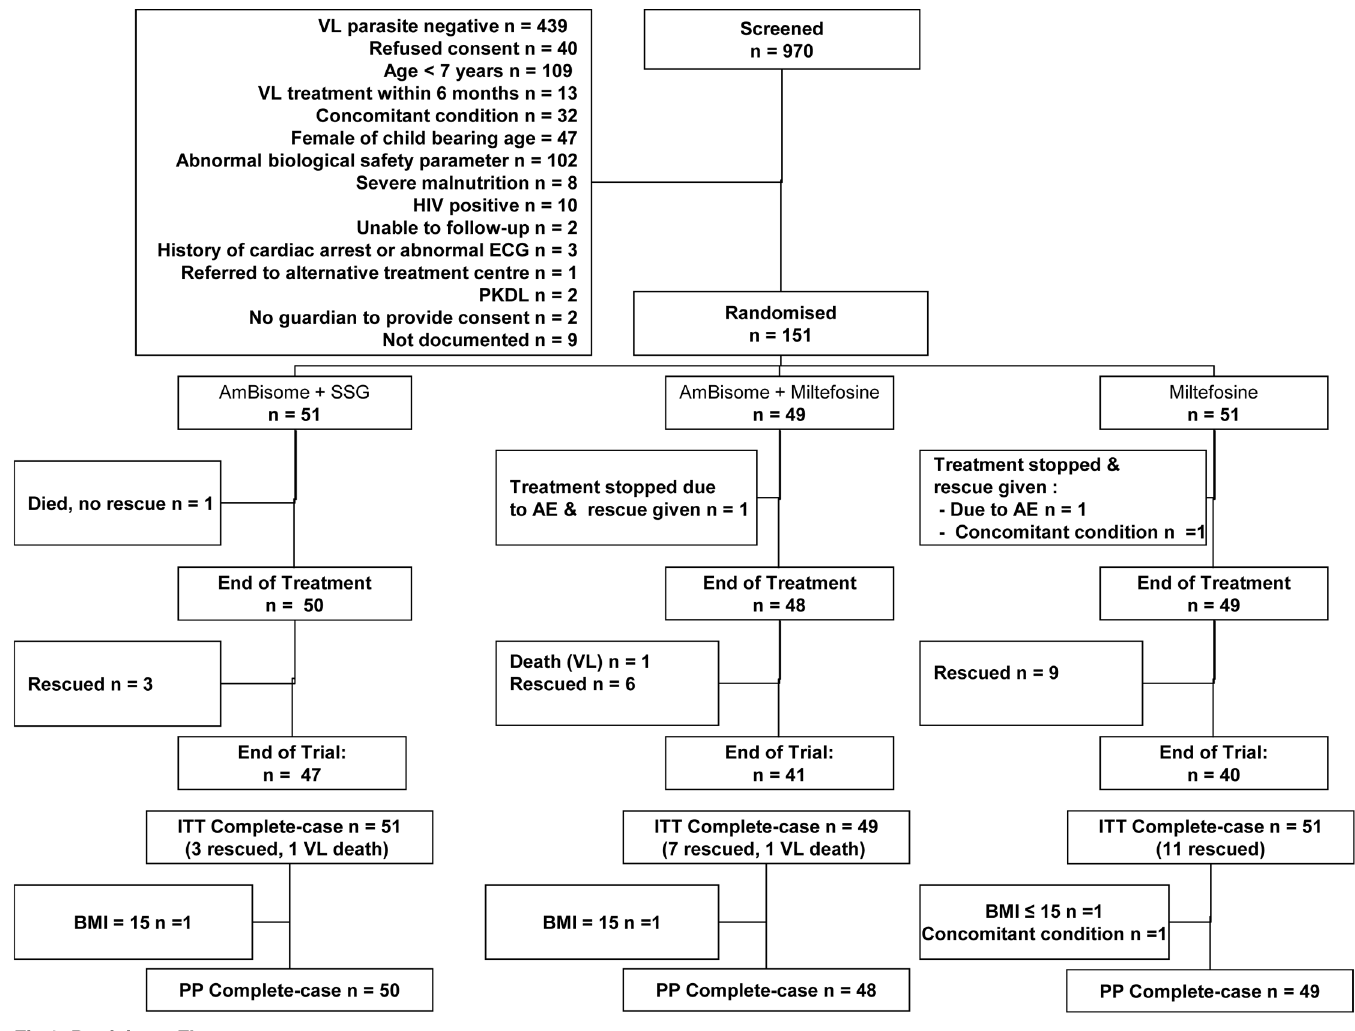
Fig 1. Participant Flow.